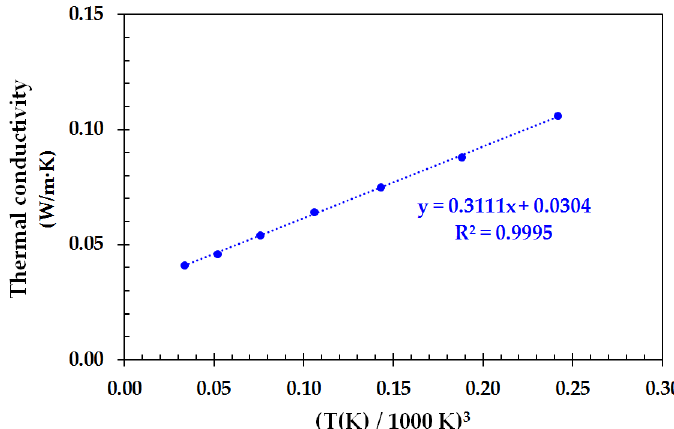
Figure 1. Thermal conductivity of the thermal insulation (ProRox PSM 971, 50 mm) as a function of the absolute temperature to the third power. Data from Appendix A, Table A2.